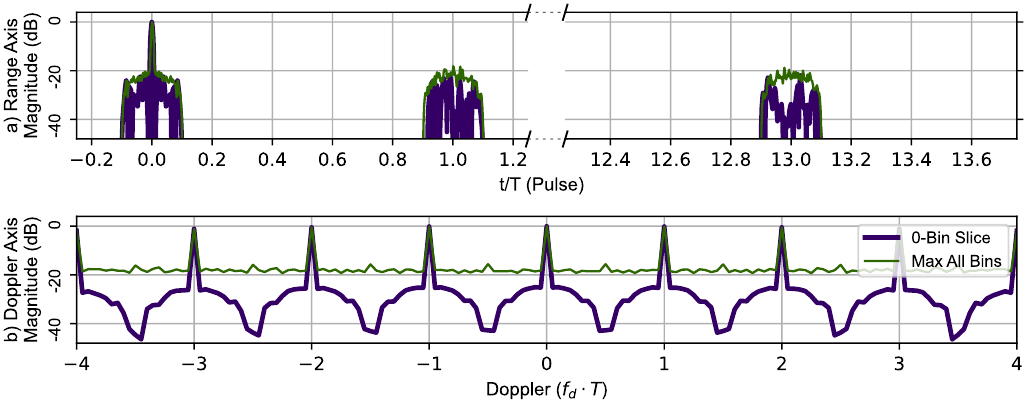
Figure 9. Ipatov–Barker method’s 78 pulse ambiguity function cross-sections in peak relative dB scale. ( a ) Top, zero Doppler cross-section (Purple), Max all Doppler cross-sections (Green). ( b ) Bottom, zero delay cross-section (Purple), Max all delay cross-sections (Green). The Doppler slice of the ambiguity function contains repeated peaks corresponding to the Doppler ambiguity.